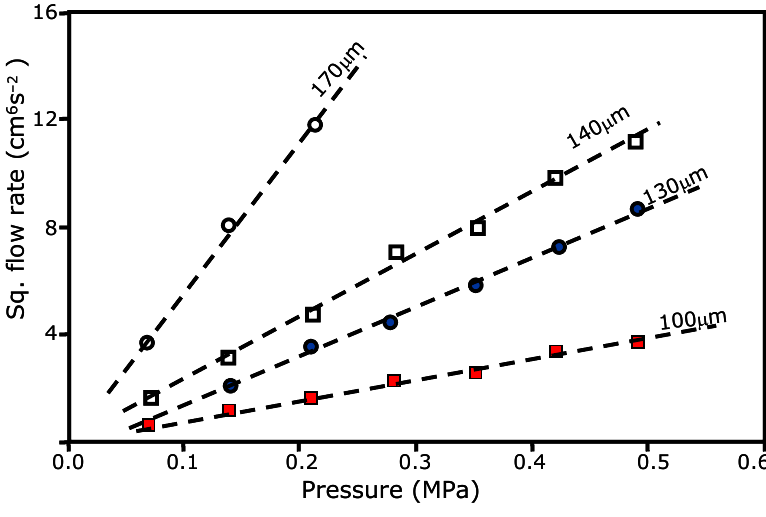
Figure 1. Flow curves showing relationships between square flow rate and applied pressure from water experiments for characterising flow